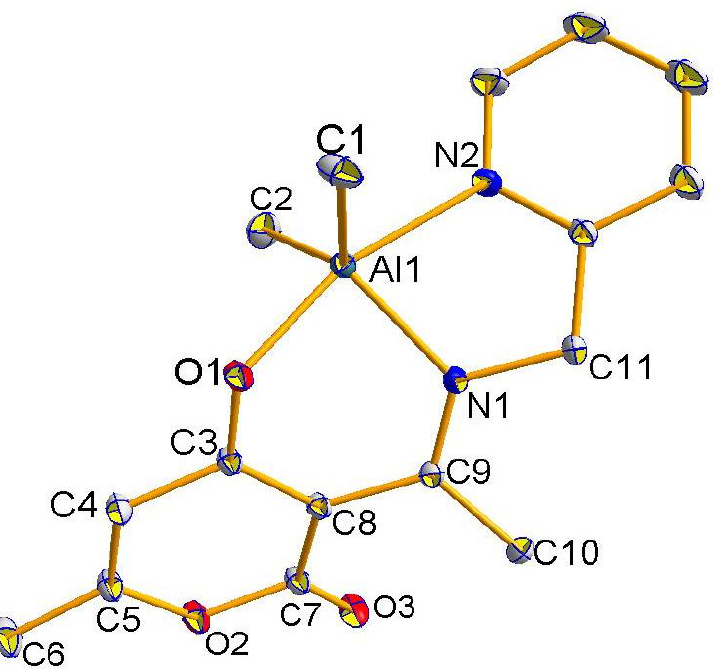
Figure 4. The molecular geometry of compound 4 . Thermal ellipsoids are drawn at the 30% probability level. THF and all the hydrogen atoms are omitted for clarity.